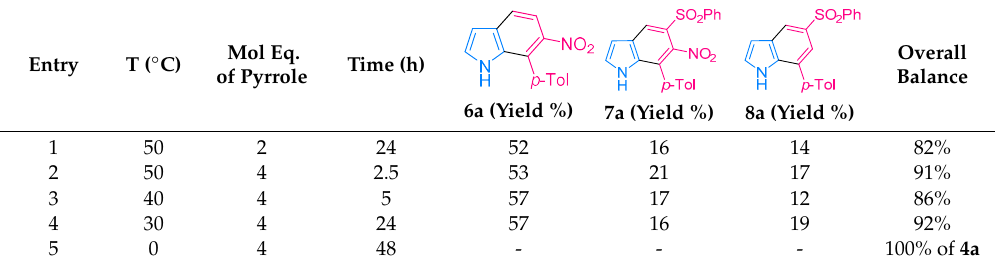
Molecules 2019 , 24 , x FOR PEER REVIEW Table 1. Search for conditions of choice in the reactions of nitrobutadiene 4a with pyrrole 1 .